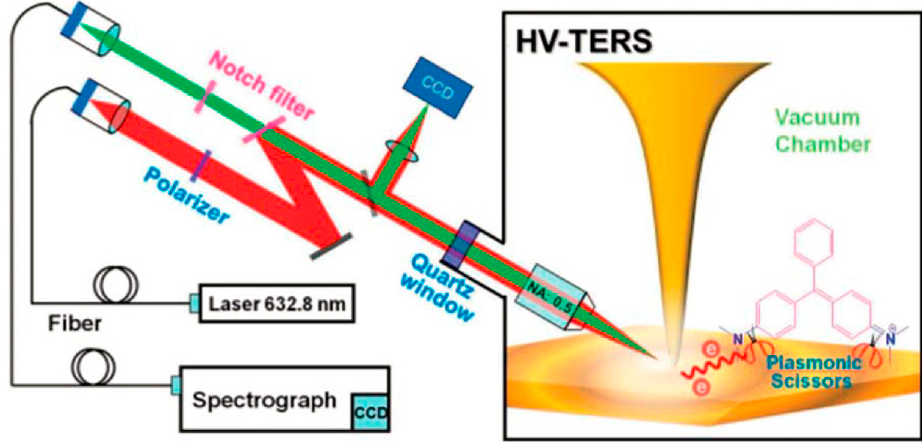
Figure 2. Home-made setup of high-vacuum tip-enhanced Raman spectroscopy (HV-TERS) and mechanism of resonant dissociation by plasmonic scissors. Hot electrons are excited by laser light in the nanogap of a TERS setup to cut molecular bonds in the substrate-adsorbed Malachite Green (MG) molecules. Adapted from [9].